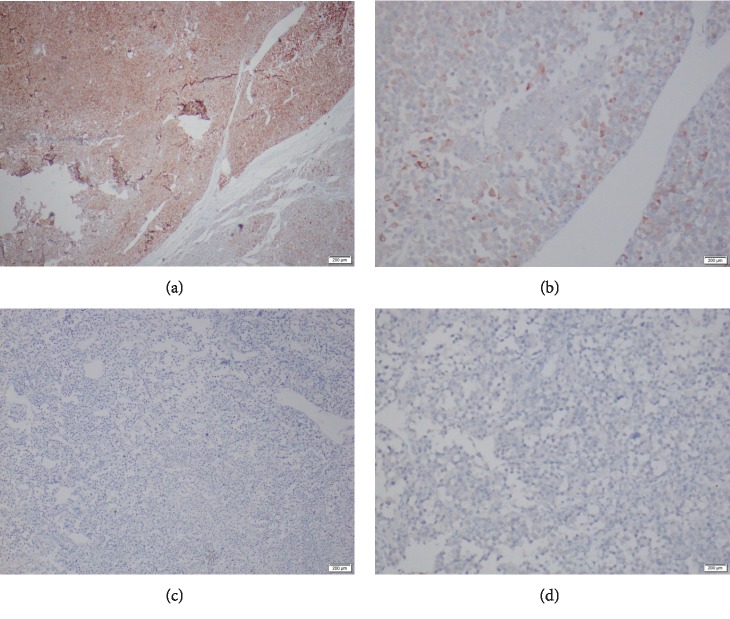
Immunohistochemical staining: (a) synaptophysin stain (patchy positivity), (b) inhibin stain (focal cytoplasmic positivity), (c) Chromogranin stain (negative), and (d) Pan CK stain (negative).